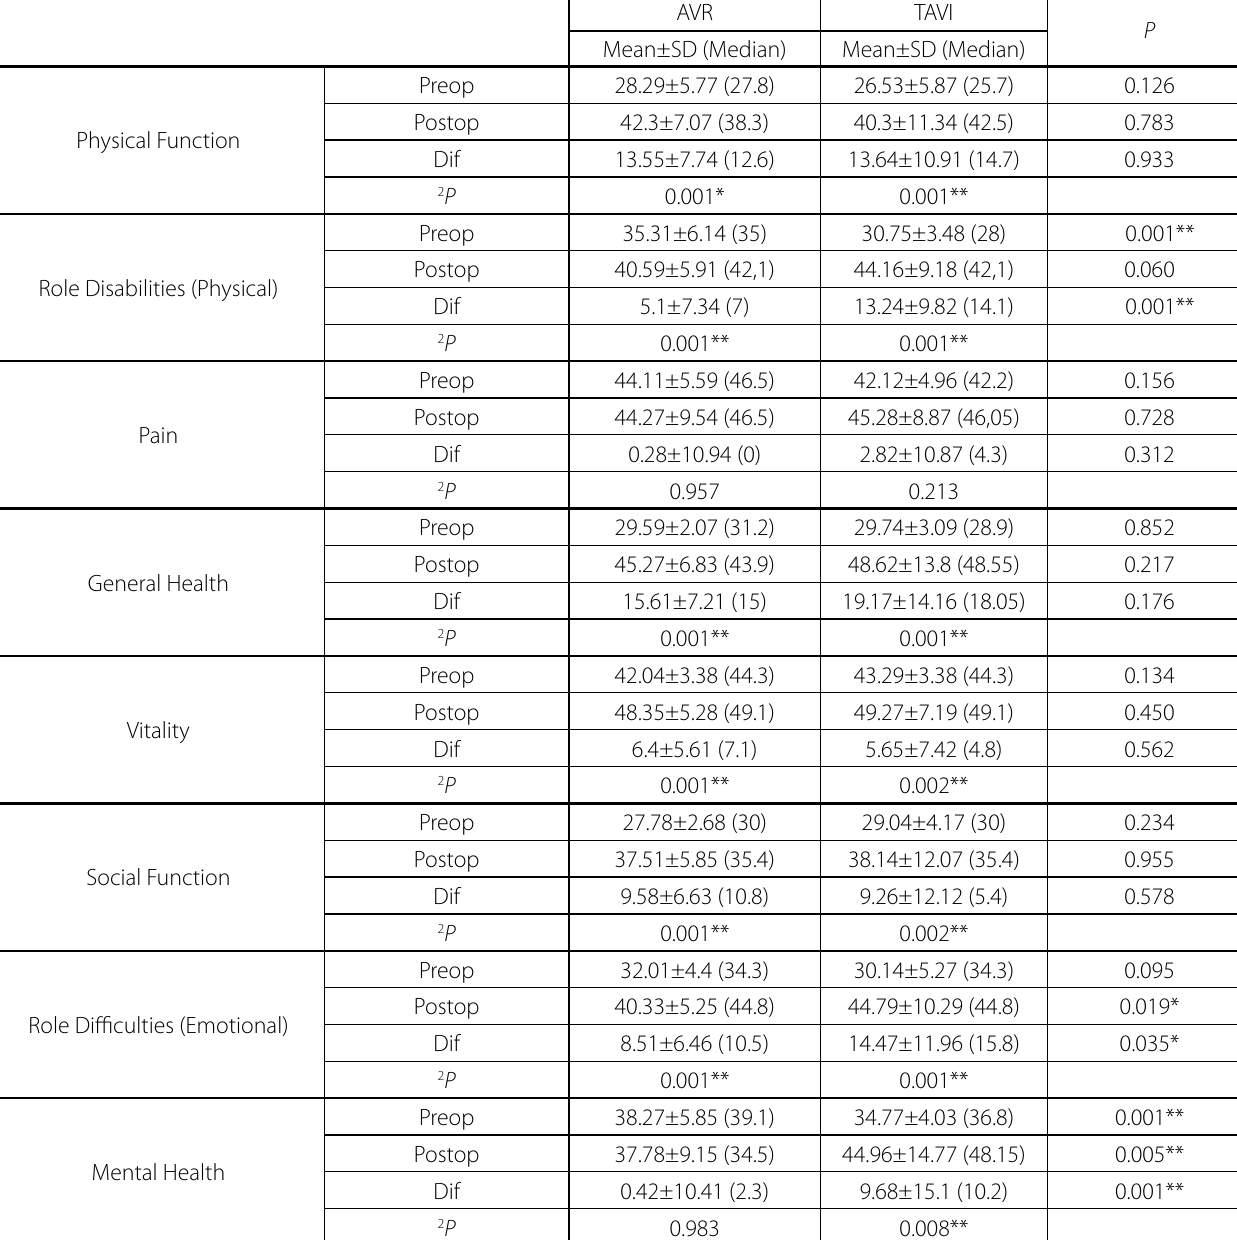
Table 2. Evaluation of the SF-36 scores according to